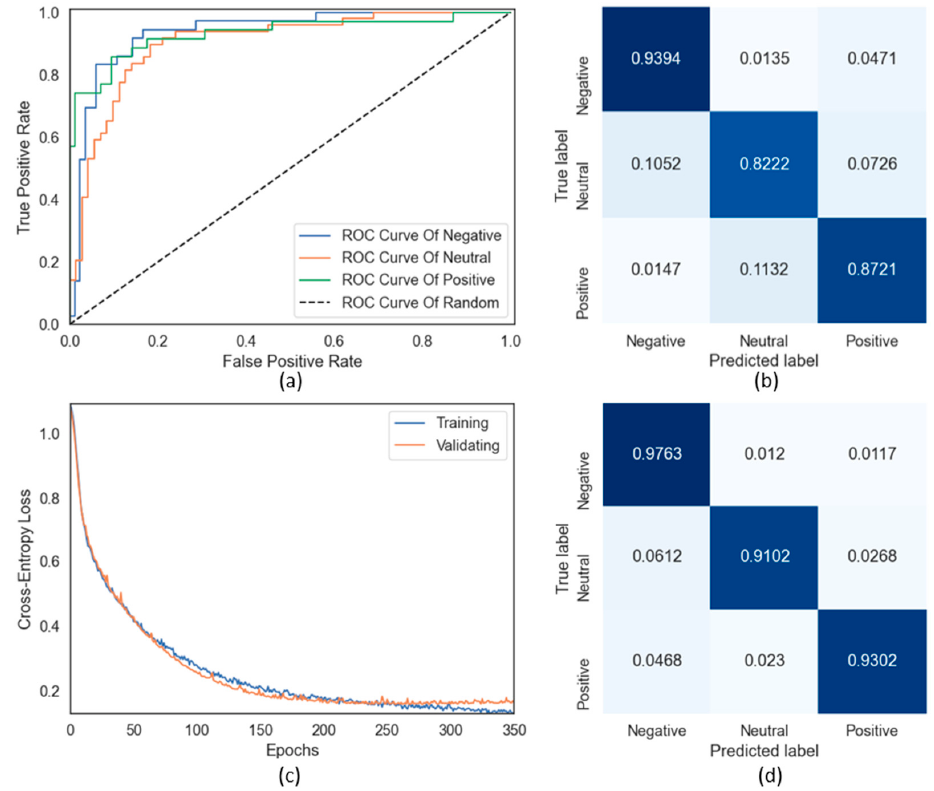
Figure 11. The results for SAE feature on Subject 2: ( a ) ROC curves for the SVM classifier; ( b ) normalized confusion matrix of the SVM classifier; ( c ) loss curve of the proposed 1D-CNN; ( d ) normalized confusion matrix of the proposed 1D-CNN.